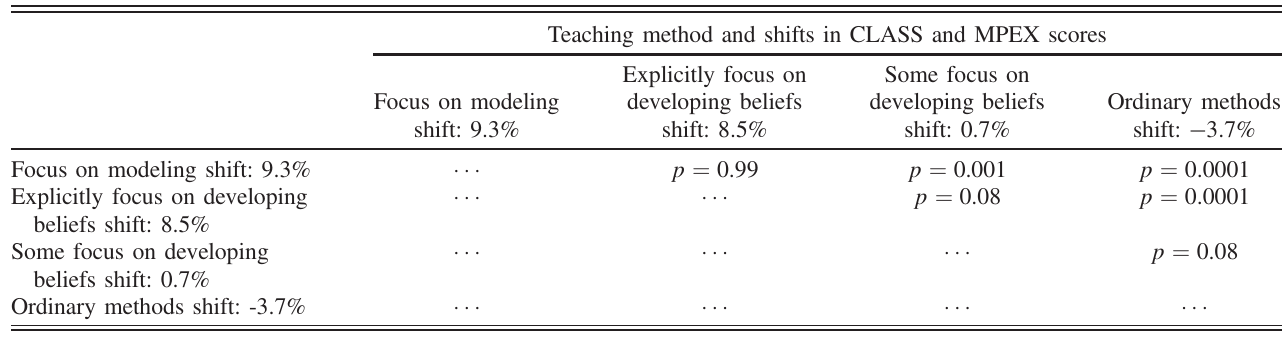
TABLE VII. Results of Tukey-HSD post hoc pairwise contrasts comparing shifts for different teaching